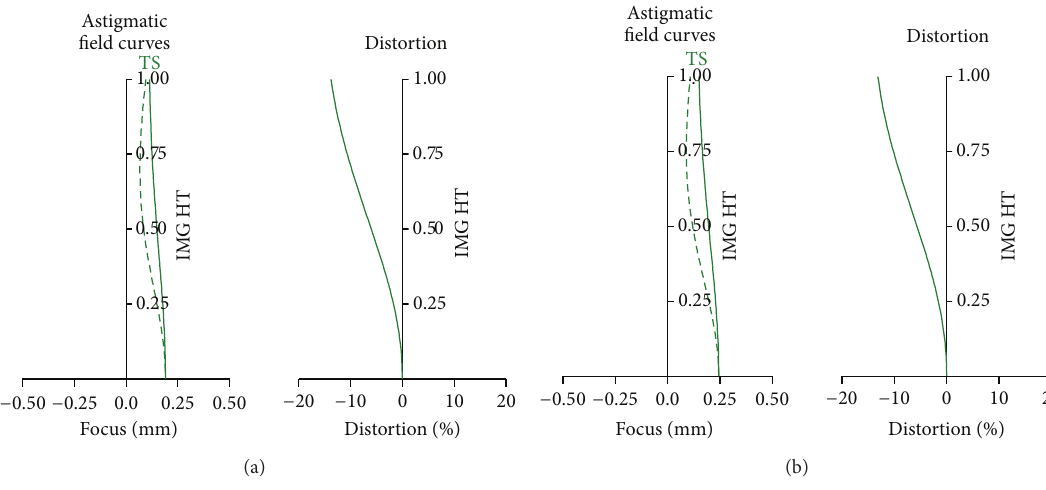
Figure 7: Field curvature: (a) EFL = 5 mm and (b) EFL = 7 mm.